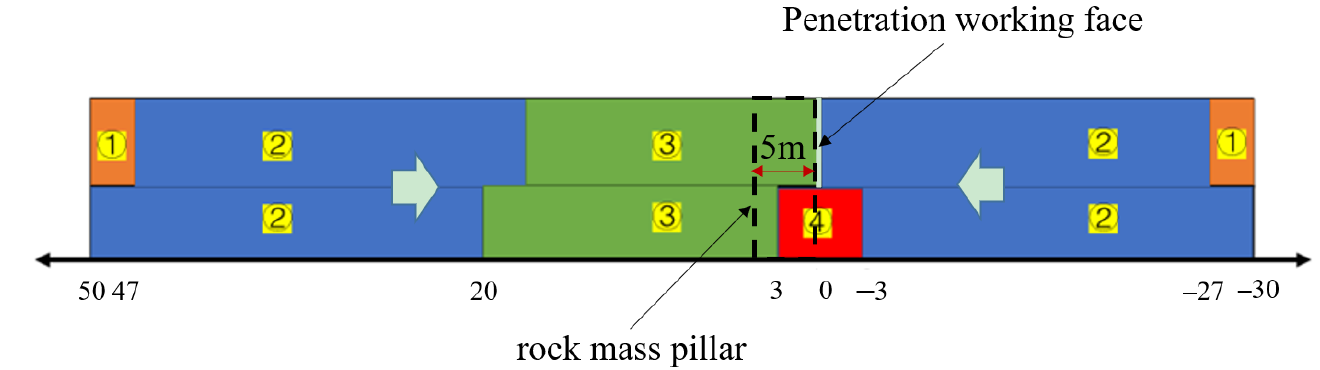
Figure 12. Schematic diagram of the excavation from 5 m rock pillars left on the construction entrance side to tunnel penetration.